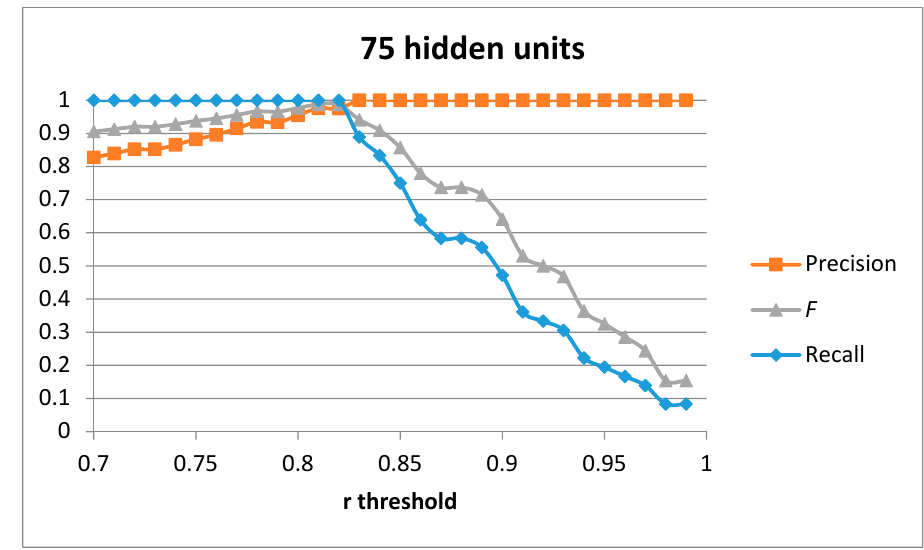
Figure 5. Precision, recall, and F score for 1 auto-encoder and 75 hidden units.